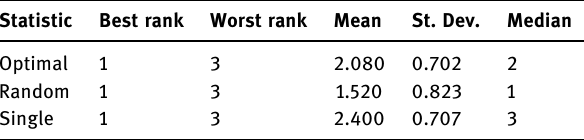
Table 2: Summary statistics for ranking the di ff erent videos Statistic